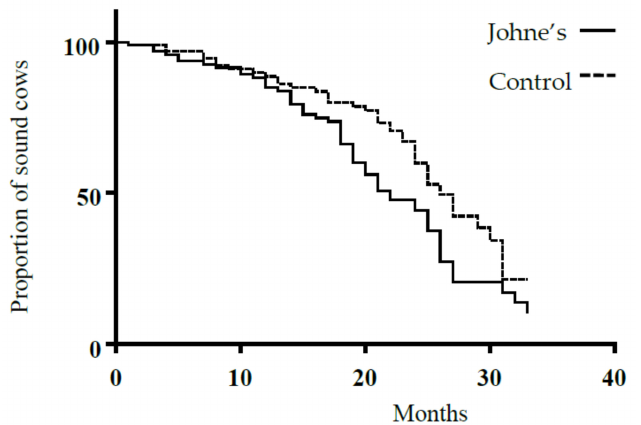
Figure 1. Time elapsed until the occurrence of a lameness event in cows diagnosed with Johne’s disease compared to their lactation matched seronegative